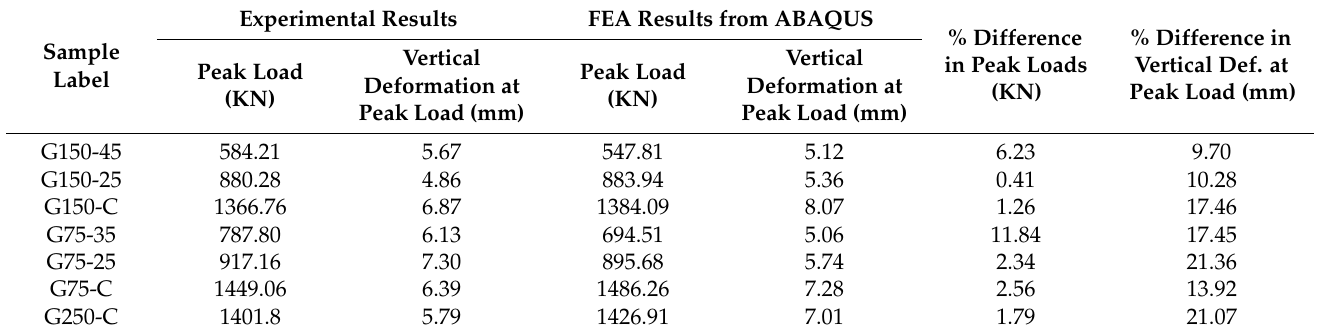
Table 4. Testing and numerical simulation